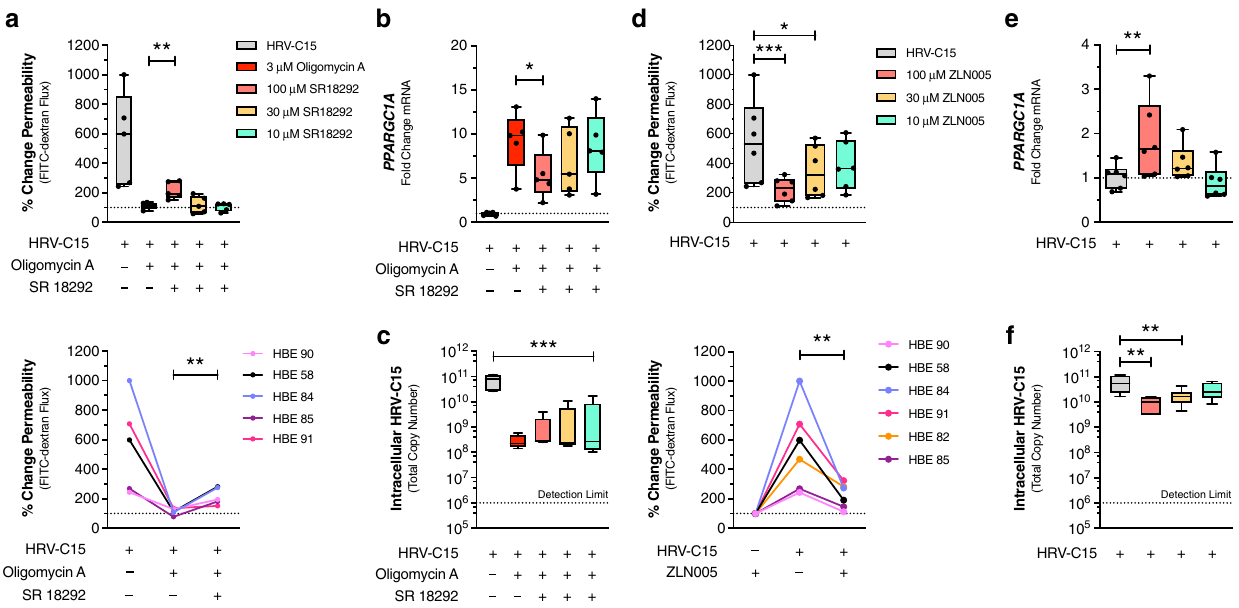
Fig. 6 PGC-1 α restores barrier function and serves as a novel antiviral. a SR18292 (PGC-1 α inhibitor) dose response on oligomycin A-treated ALI cultures measuring FITC-dextran (3 – 5 kDa) fl ux 12 h post infection (top). Loss of oligomycin A barrier restoration by 100 μ M SR18292 (bottom). Data are represented as boxplots and individual HBE donor lines and analyzed by one-way ANOVA with Dunnett multiple comparisons: ** p = 0.005, n = 5 donors. b PPARGC1A mRNA expression by treatment with 3 μ M oligomycin A in the presence of SR18292 at 12 h post infection, measured by RT-PCR. Data are represented as boxplots and analyzed by one-way ANOVA with Dunnett multiple comparisons: * p = 0.02, n = 5 donors. c Matched HRV-C15 intracellular RNA copy number at 12 h post infection, quanti fi ed by RT-PCR. Dashed line represents RT-PCR detection limit. There was no detectable HRV-C15 in noninfected ALI cultures. Data are represented as boxplots and analyzed by one-way ANOVA with Dunnett multiple comparisons: *** p = 0.0002, n = 5 donors. d ZLN005 (PGC-1 α activator) dose response in HRV-C15-infected ALI cultures measuring FITC-dextran (3 – 5 kDa) fl ux at 12 h post infection (top). HRV-C15 barrier recovery by 100 μ M ZLN005 at 12 h post infection (bottom). Data represented as boxplots and individual donor lines and analyzed by one-way ANOVA with Holm – Sidak multiple comparisons: *** p = 0.0008, ** p = 0.03, n = 6 donors. e PPARGC1A mRNA expression in response to ZLN005 treatment, measured at 12 h post infection. Data are represented as boxplots and analyzed by one-way ANOVA with Dunnett multiple comparisons: ** p = 0.002, n = 6 donors. f Matched HRV-C15 intracellular RNA copy number, quanti fi ed by RT-PCR. Dashed line represents RT-PCR detection limit. There was no detectable HRV-C15 in noninfected cultures. Data are represented as boxplots and analyzed by one-way ANOVA with Holm – Sidak